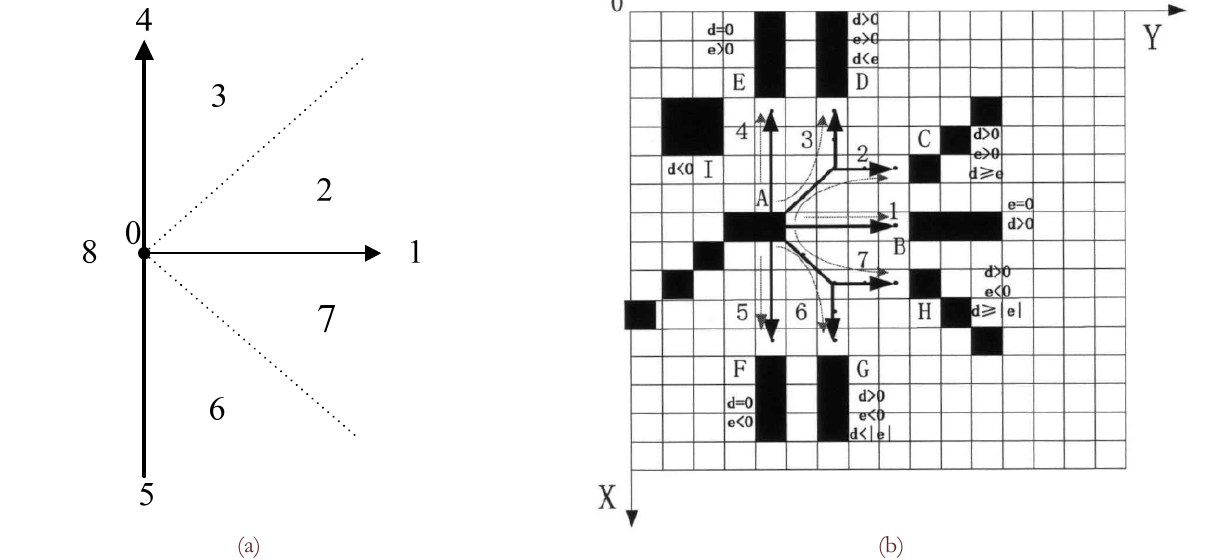
Figure 5: (a) Location model; (b) Connecting model of the crack fragment’s